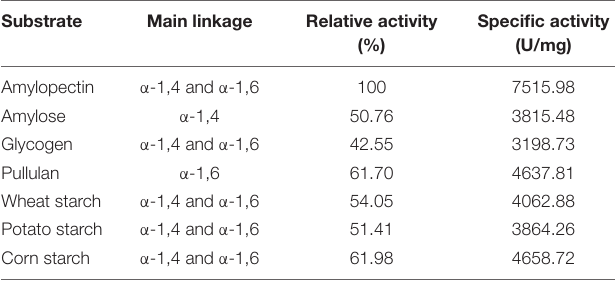
TABLE 1 | Substrate specificity of the purified PersiAmy1.